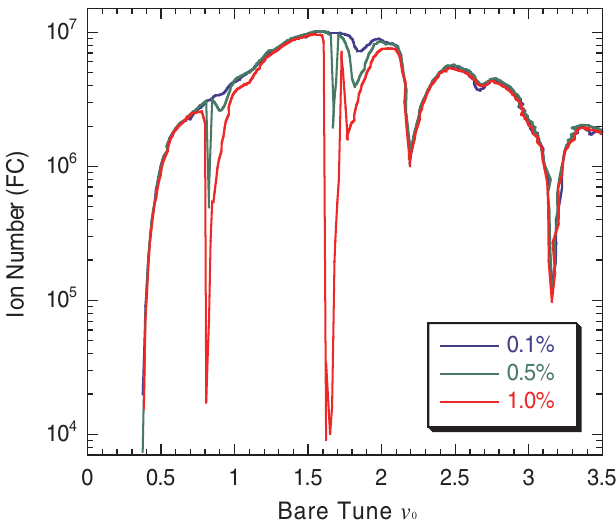
FIG. 7. (Color) Experimental results in the high-density regime where the number of trapped ions is about 100 times more than presented in Fig. 6. Three different amplitudes of the N sp ¼ 3 wave have been considered; 0.1%, 0.5%, and 1.0% of the N sp ¼ 12 primary-wave amplitude. The instability region near (cid:4) 0 : 75 contains two overlapping resonances that appear to corre- spond to mode numbers ð m; n Þ ¼ ð 2 ; 1 Þ and (4, 2). Large particle losses near (cid:4) 0 (cid:3) 1 : 5 are likely caused by the instability of linear and fourth-order collective modes with ð m; n Þ ¼ ð 2 ; 2 Þ and (4, 4). The plasma storage time is 1 msec.